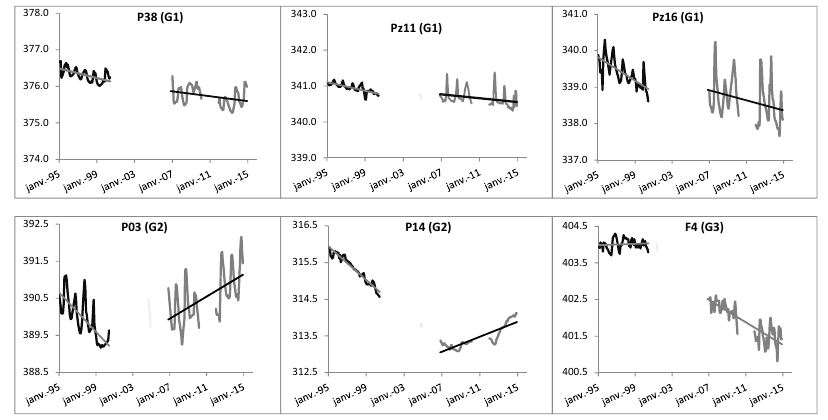
Figure 4. Interannual variations of the groundwater levels (m.a.s.l) from 1995 to 2014, for a representative sample of piezometers.